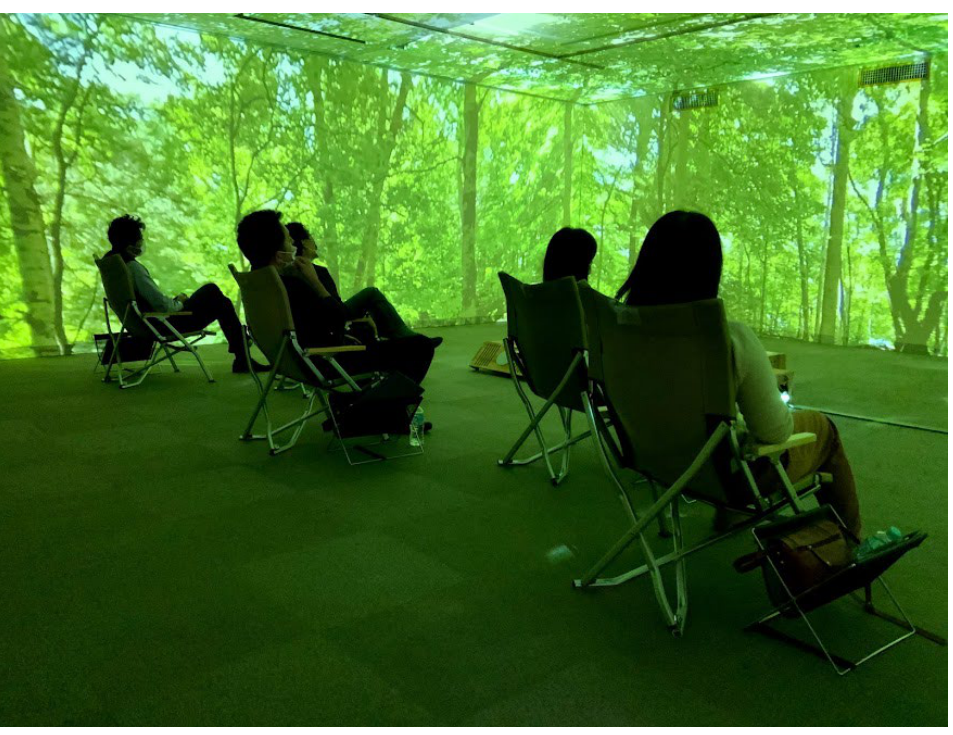
Figure 5. The experiment in